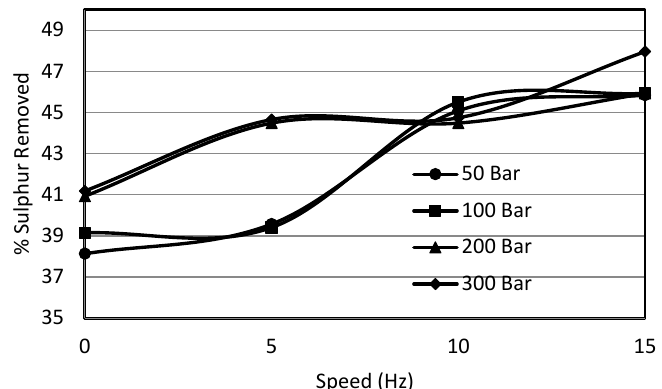
Figure 6. Effect of Impeller Speed on pyritic sulphur removal.